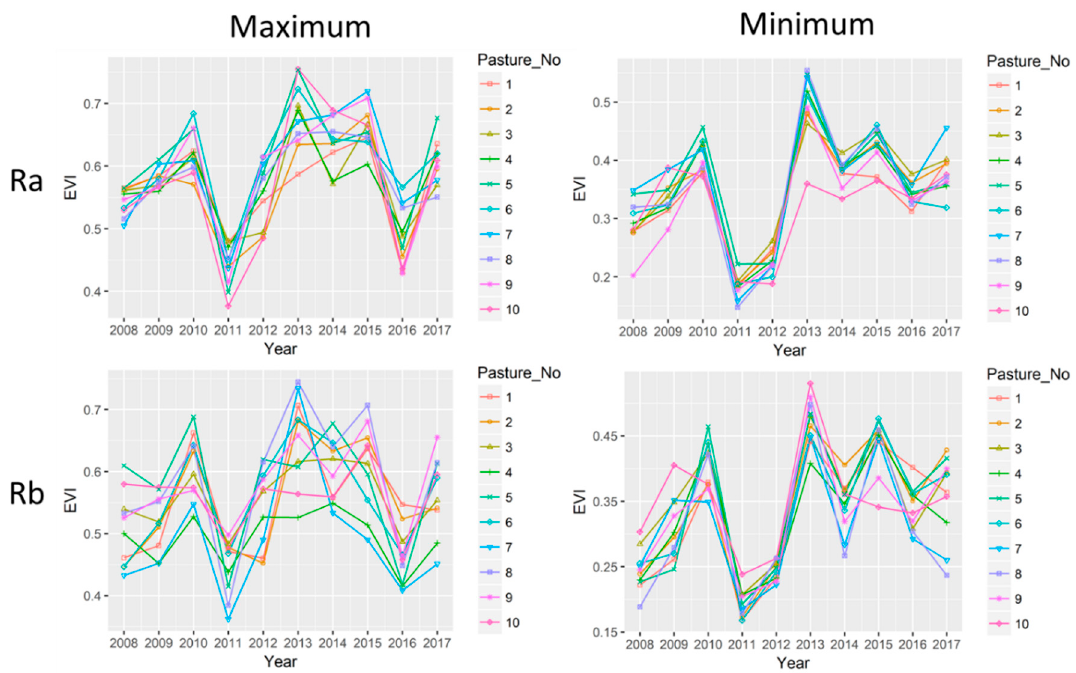
Figure 10. Growing season maximum and minimum EVI from Landsat 7 for paddocks in rotational grazing.